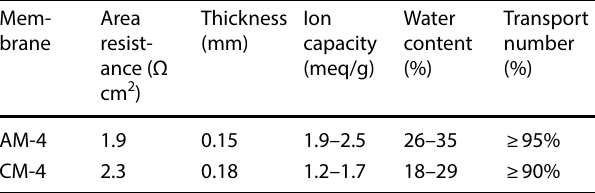
Table 1 The properties of three kinds of membranes Mem- Area brane